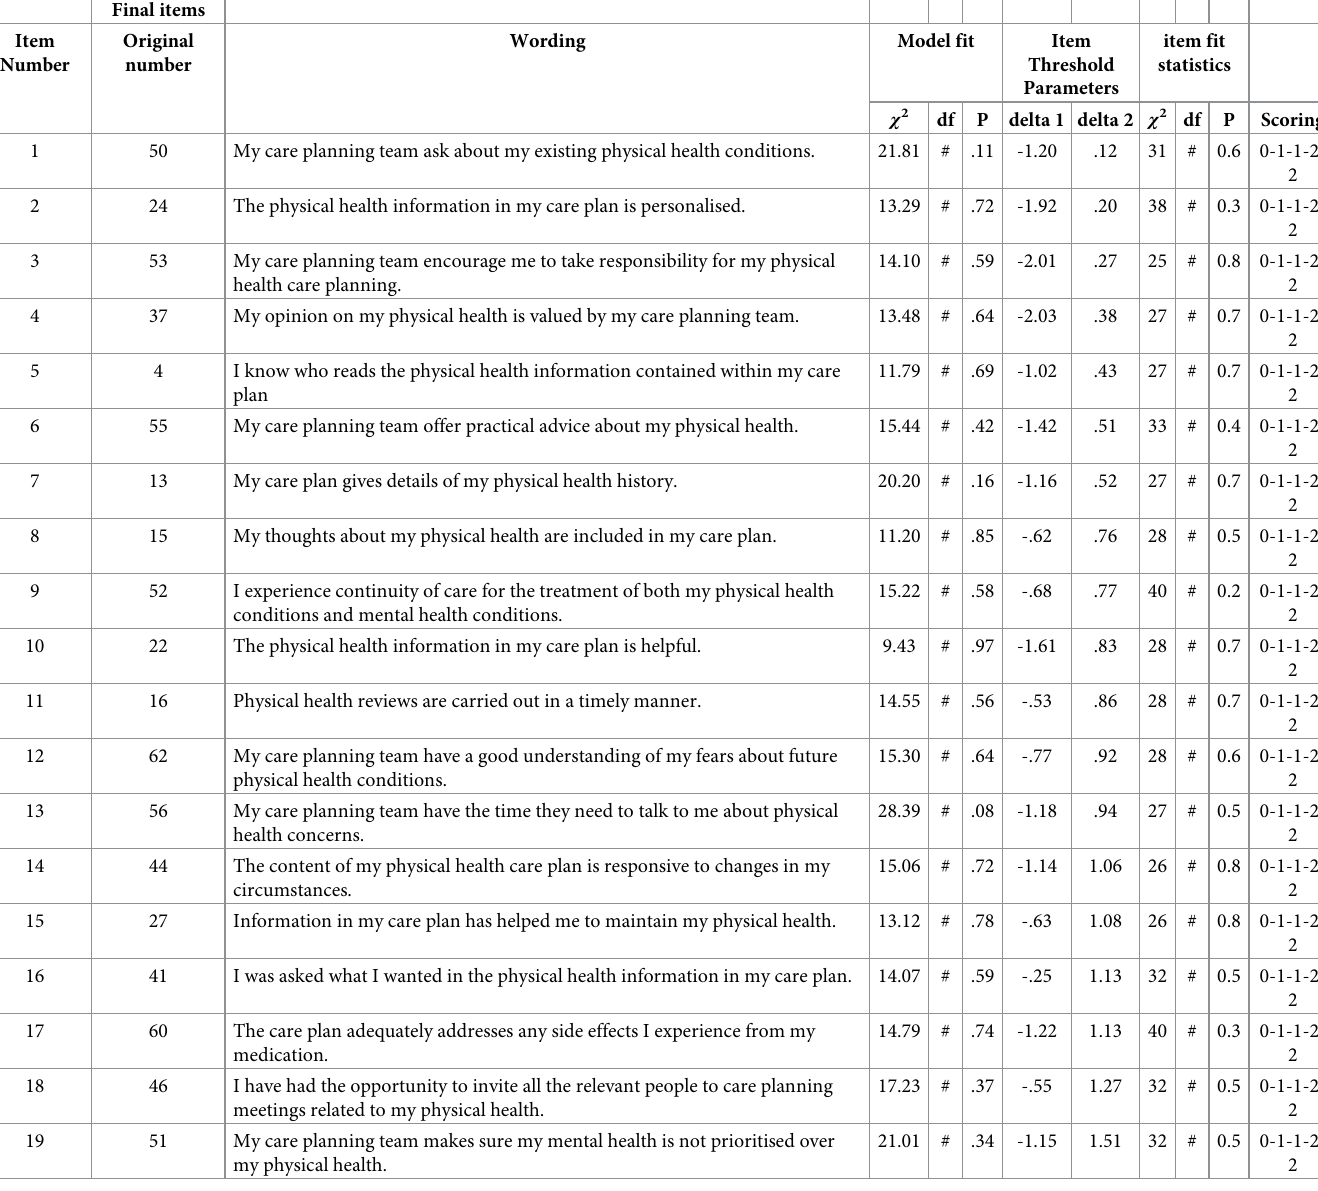
Table 2. Details of final items and item threshold